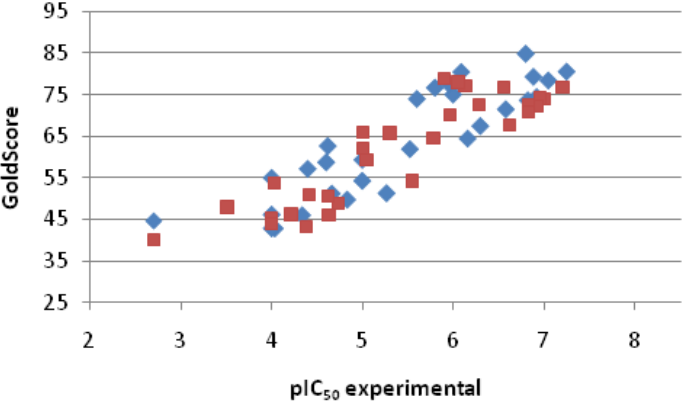
Figure 4. Plot of score vs. experimental pIC inhibitors. Each set contains 30 compounds (blue marks: training set; and red marks: test